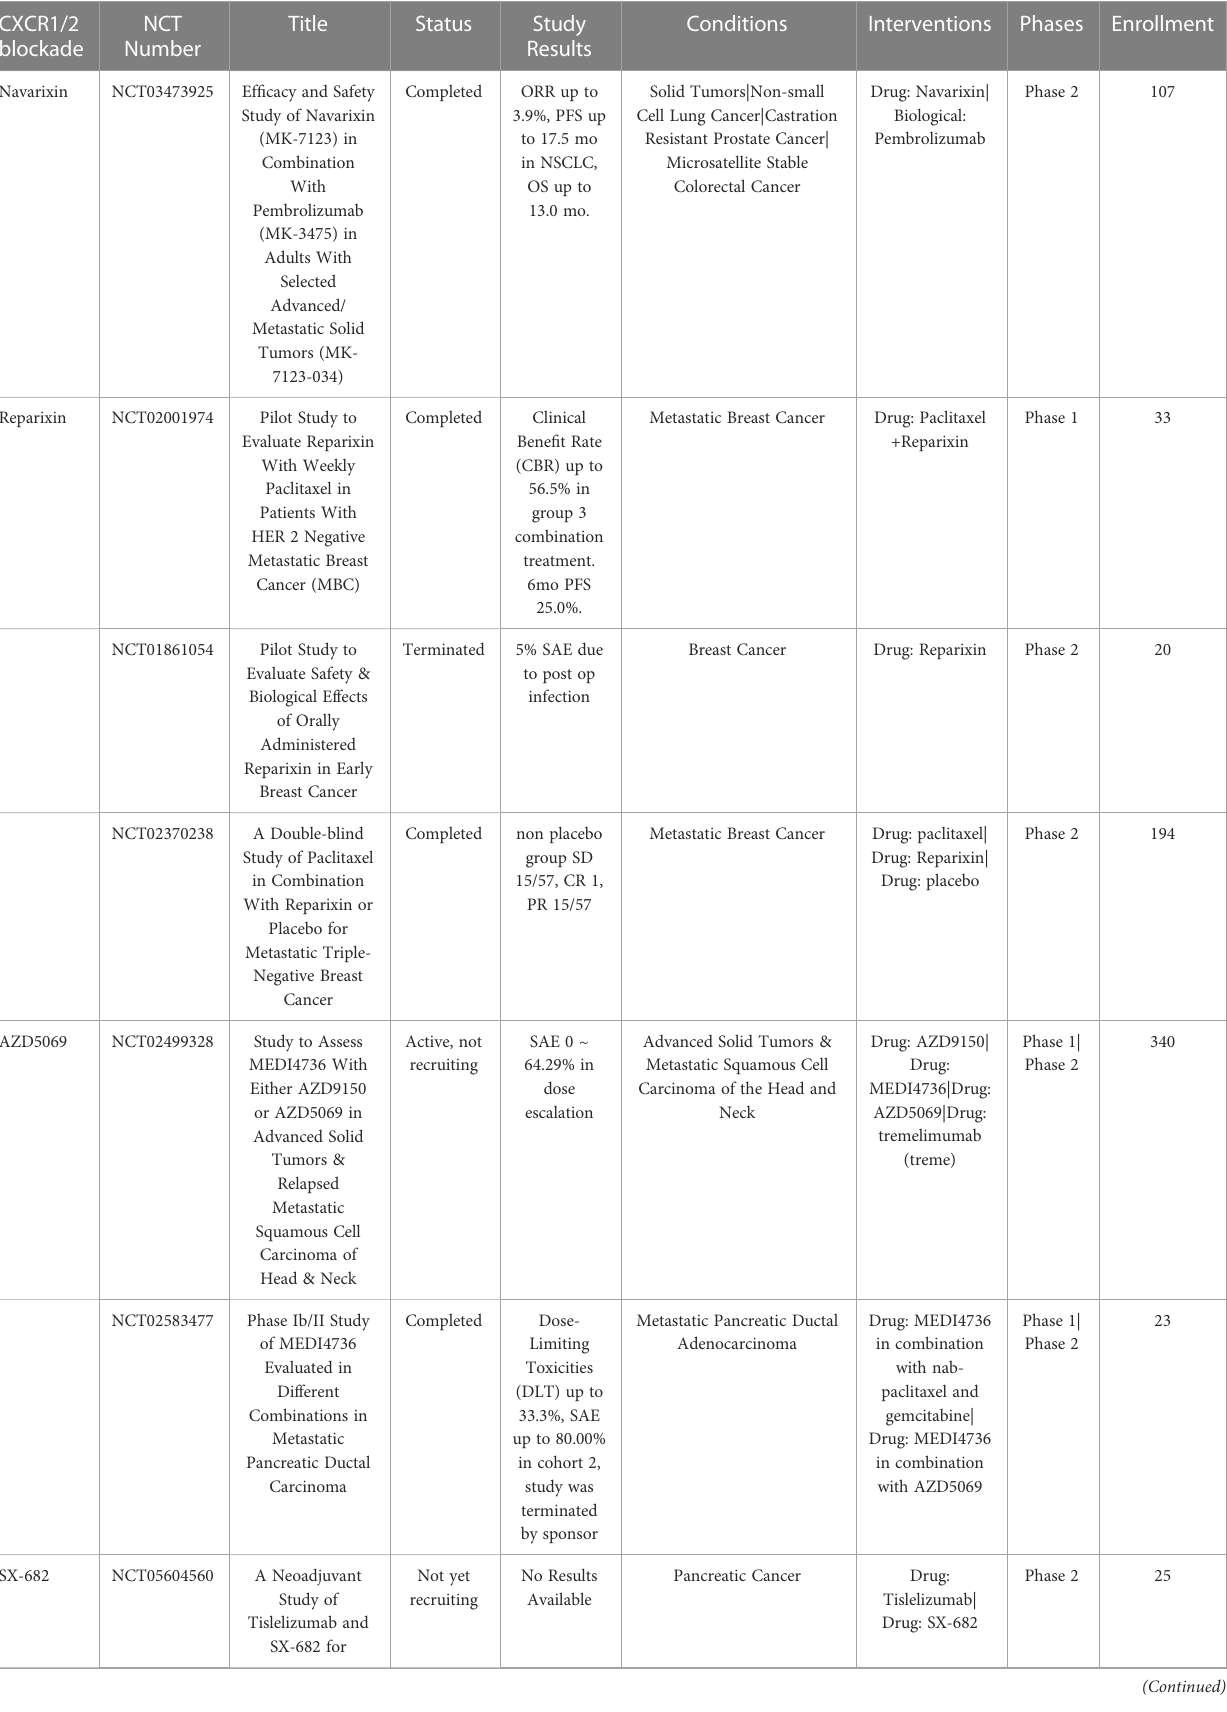
TABLE 6 US clinical trials using CXCR1 antagonists for cancer treatment. CXCR1/2